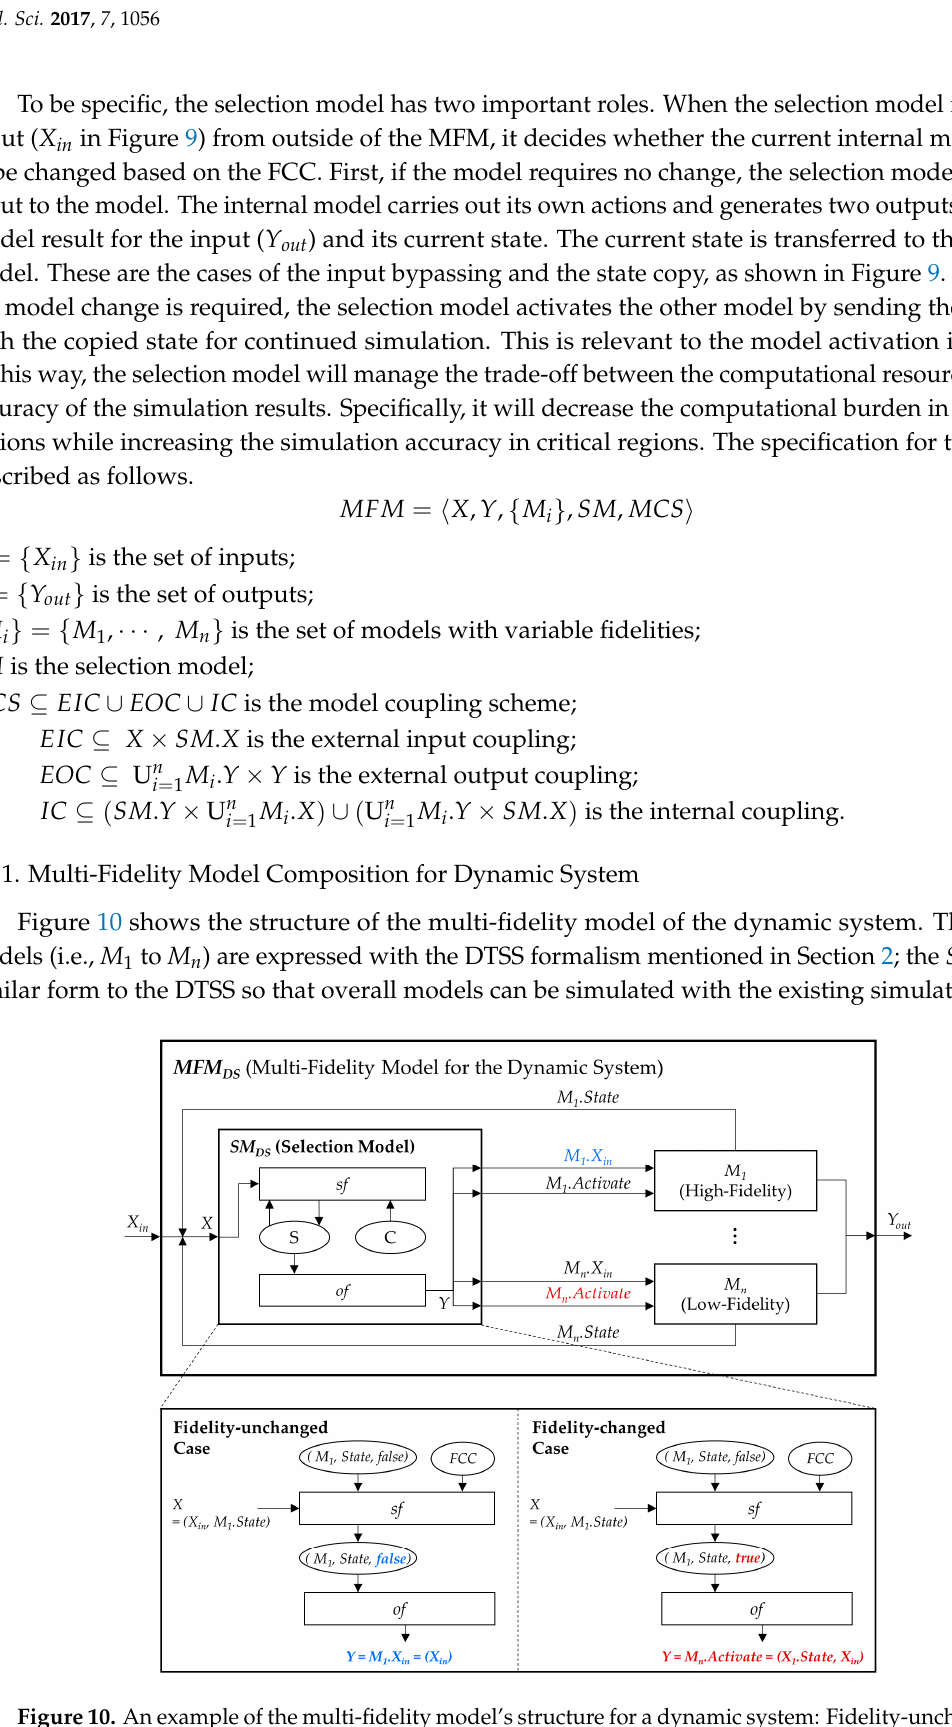
Figure 10. An example of the multi-fidelity model’s structure for a dynamic system: Fidelity-unchanged and fidelity-changed cases.